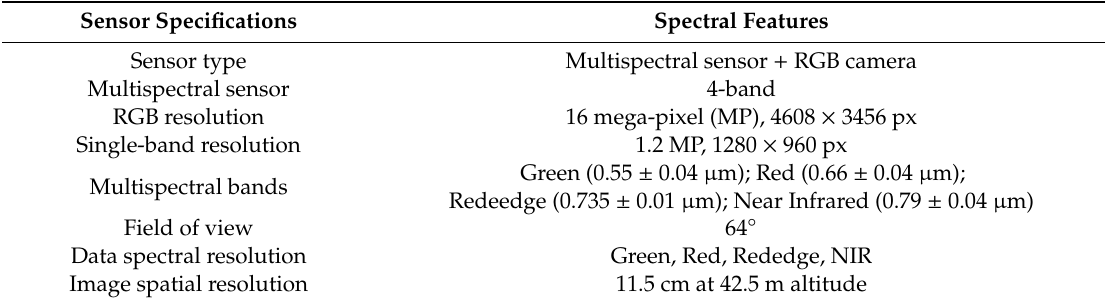
Table 1. UAV sensor parameters and spectral ranges for the Red (R), Green (G), Rededge (RE), and Near-Infrared (NIR) bands of the camera used in this